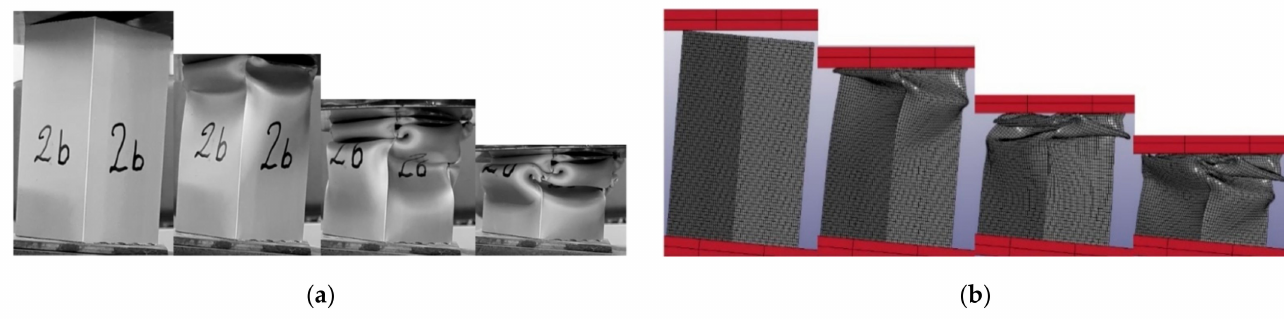
Figure 11. Plastic deformation progress of 5 ◦ crushing angle for cornered oblique impact. ( a ) experiment; ( b ) simulation.